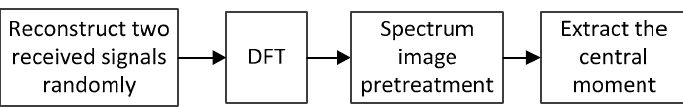
Figure 4. Sketch map of central moment feature extraction.